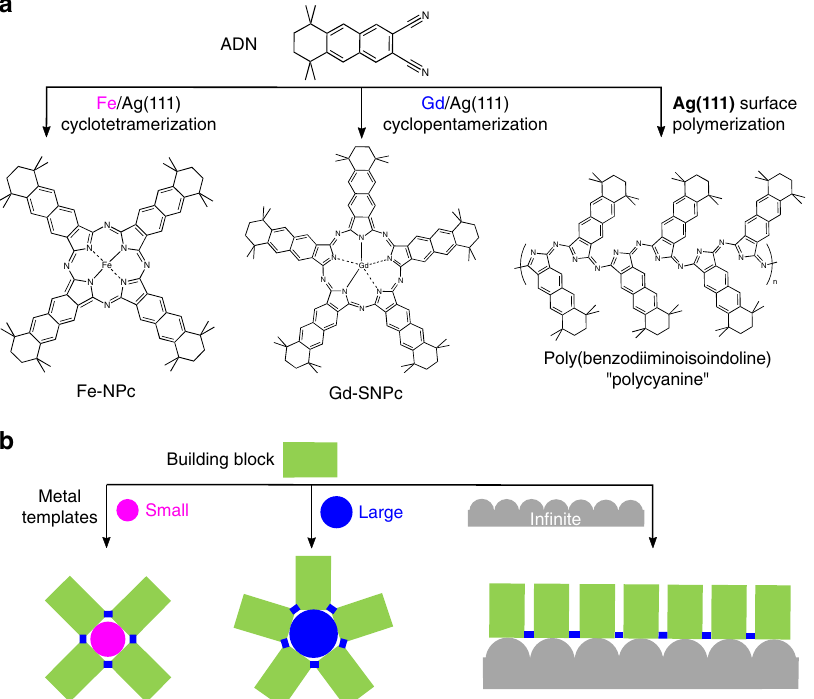
Fig. 1 Reaction scheme and concept. a Reactions of the precursor monomer 5,5,8,8-tetramethyl-5,6,7,8-tetrahydroanthracene-2,3-dicarbonitrile (ADN) with different metal templates (Fe, Gd) on Ag(111), resulting in the formation of iron-naphthalocyanine (Fe-NPc) and gadolinium-supernaphthalocyanine (Gd-SNPc). Using the bare Ag(111) surface as a laterally extended template leads to surface-catalyzed polymerization and formation of poly (benzodiiminoisoindoline), here named polycyanine. b On-surface template approach: control over the topology of the reaction products is achieved by using differently sized metal templates in 2D con fi